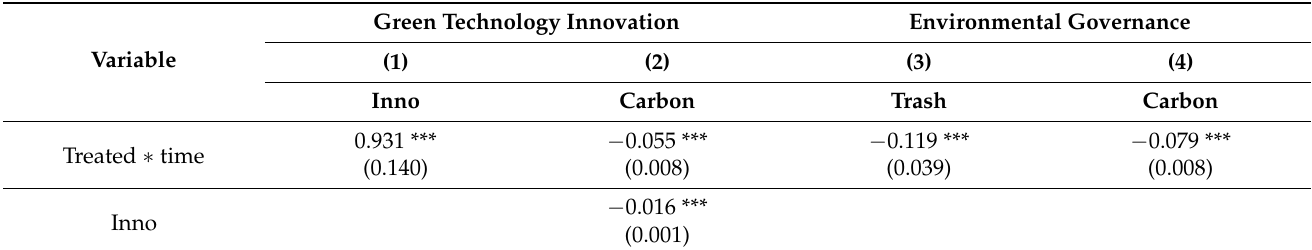
Table 8. Results of mediating effect